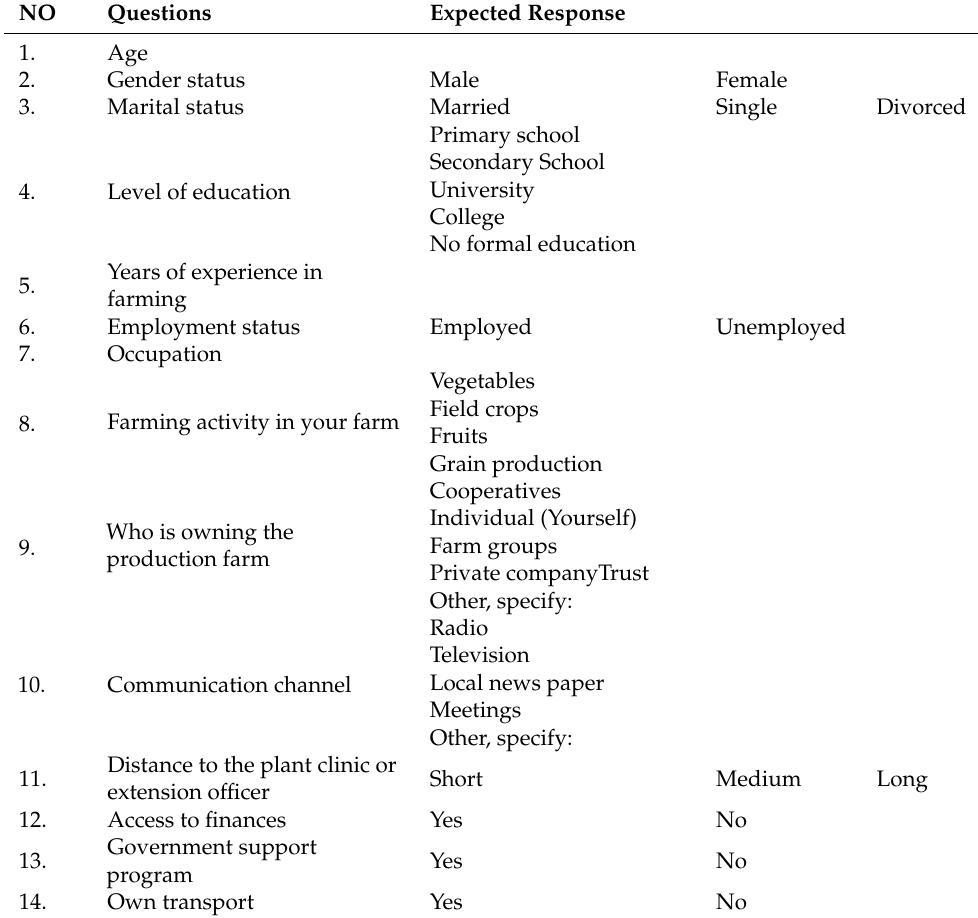
Table A1. Demographic and socio-economic information of the smallholder